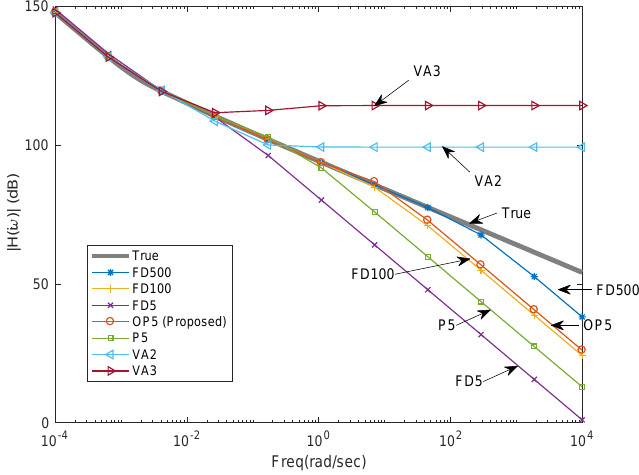
Figure 7. Frequency responses of different methods compared to the true transfer function (FD5: finite difference with 5 nodes; FD100: finite difference with 100 nodes; FD500: finite difference with 500 nodes; P5: projection with un-optimized basis; OP5: our proposed projection method with optimized basis; VA2: volume averaging with 2 basis functions; VA3: volume averaging with 3 basis functions).